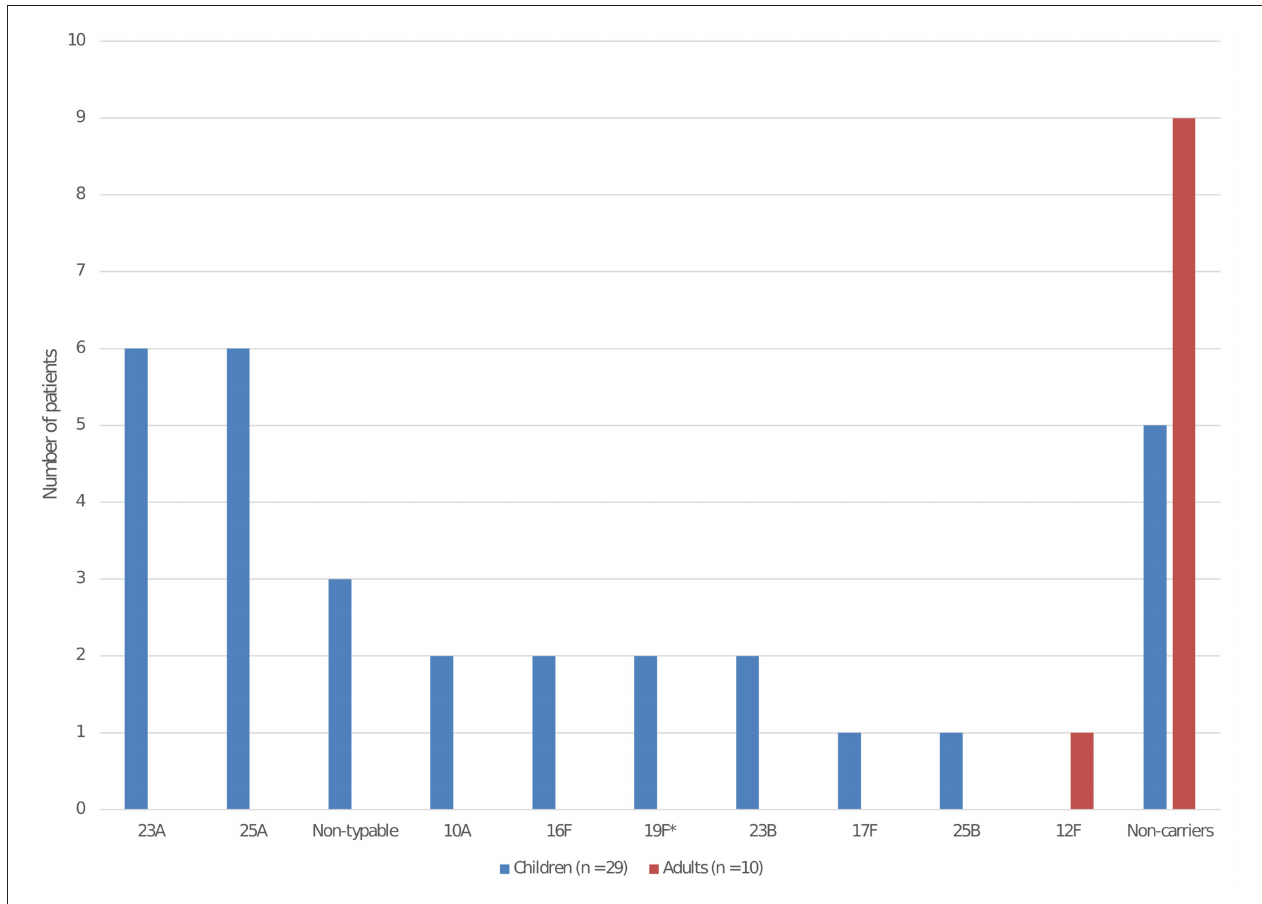
FIGURE 1 | Pneumococcal serotype distribution isolated from nasopharyngeal carriage among the children and adults in the daycare center. *Serotype included in the 13-valent pneumococcal conjugate vaccine. The serotypes involved in the 2 bacterial meningitis were 12F and 25A.